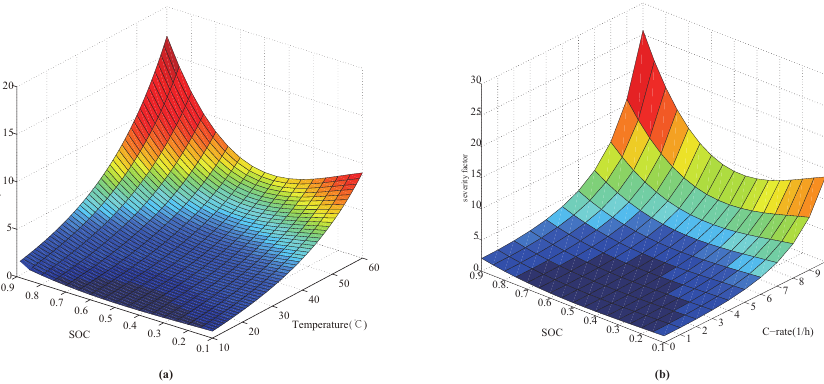
Figure 5. Severity factors’ map. Nominal cycle characteristics: C-rate = 1 (1/h), T = 25 ( ◦ C), SOC = 0.5. ( a ) Data fitting severity factors of different SOC and temperatures. ( b ) Approximate severity factors of different SOC and C-rates.